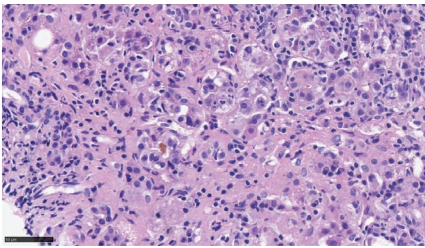
Figure 3: Another area shows canalicular cholestasis. Numerous background lymphocytes and plasma cells are also